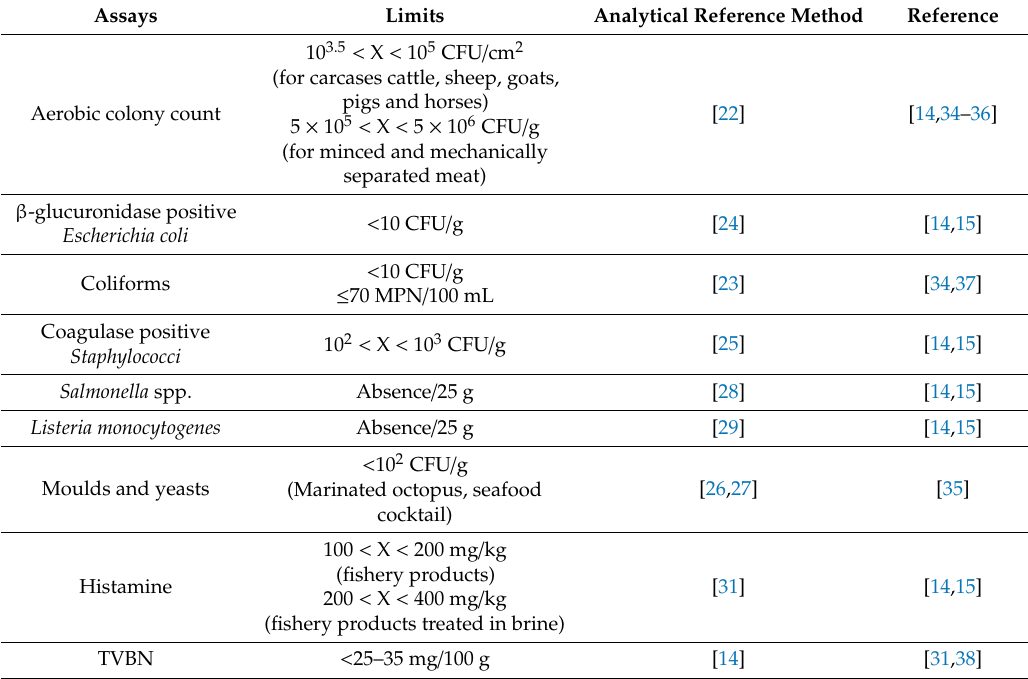
Table 1. Main safety and quality parameters identified for analysis of Jellyfish as a novel food. Assays Limits Analytical Reference Method